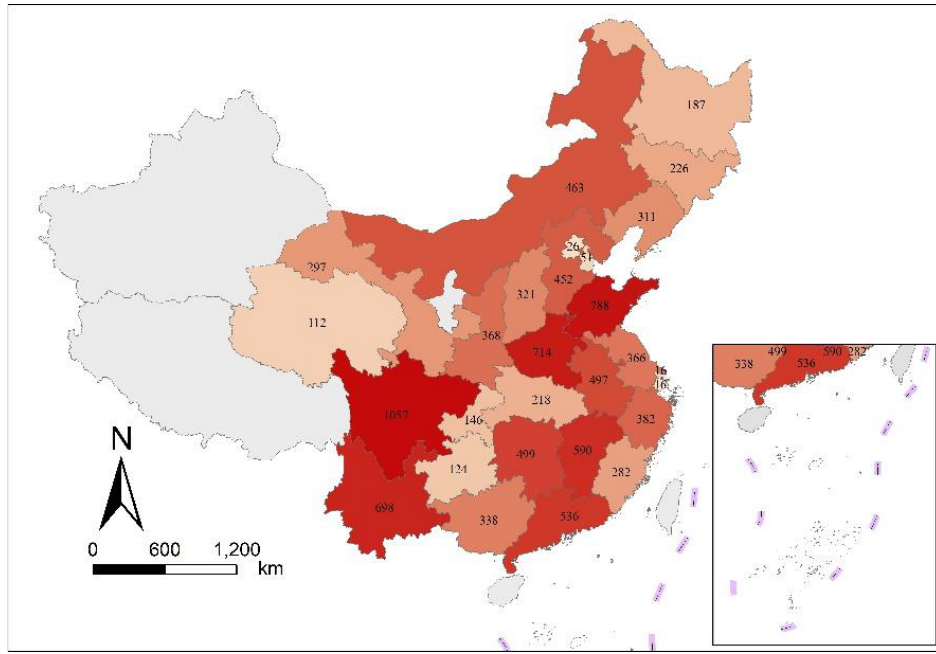
Figure 2. Provincial spatial distribution of valid samples in China.